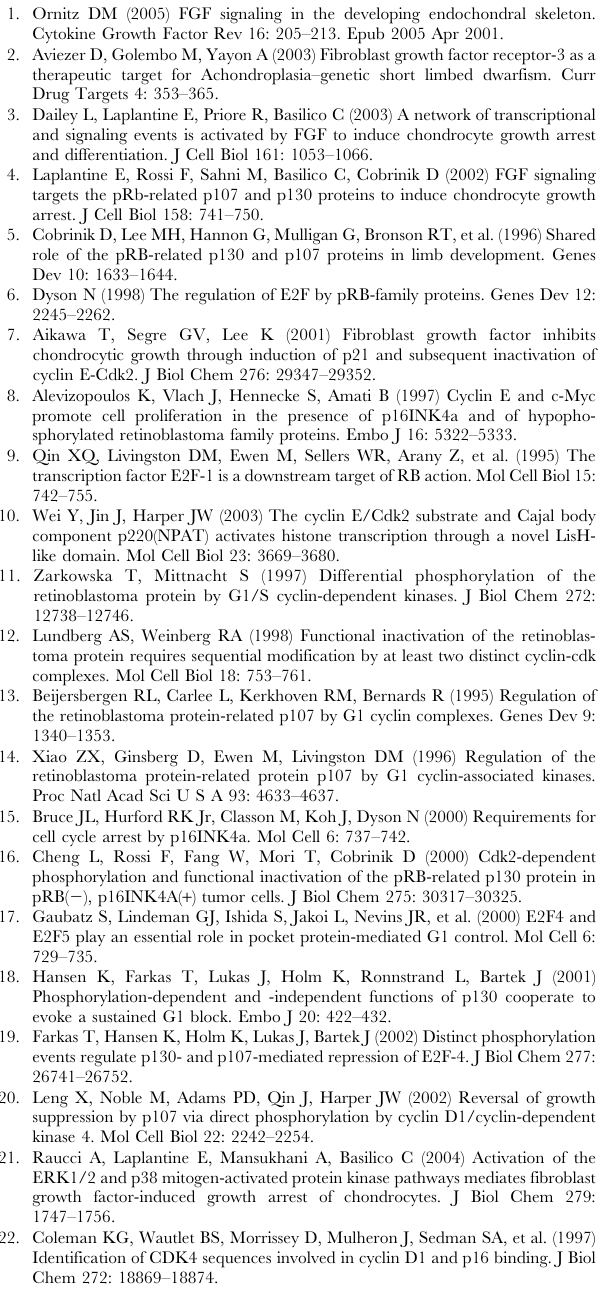
Figure S1 FGF-induced p107 dephosphorylation and ERK1/2 activation in primary chondrocytes. Chondrocytes were isolated from femoral and tibial growth plates of 10-day old mice, plated in 6-well plates and after 48 hours were treated with FGF1 for 2 hours (10 ng/ml). The cells were collected directly in 300 m l 2XSDS buffer and analyzed by SDS-PAGE followed by immunoblotting against anti-p107 and anti-phospho-ERK1/2 antibodies. Hyper-and hyposphosphorylated forms of p107 are indicated. Equal amount of protein loading was confirmed by a - tubulin